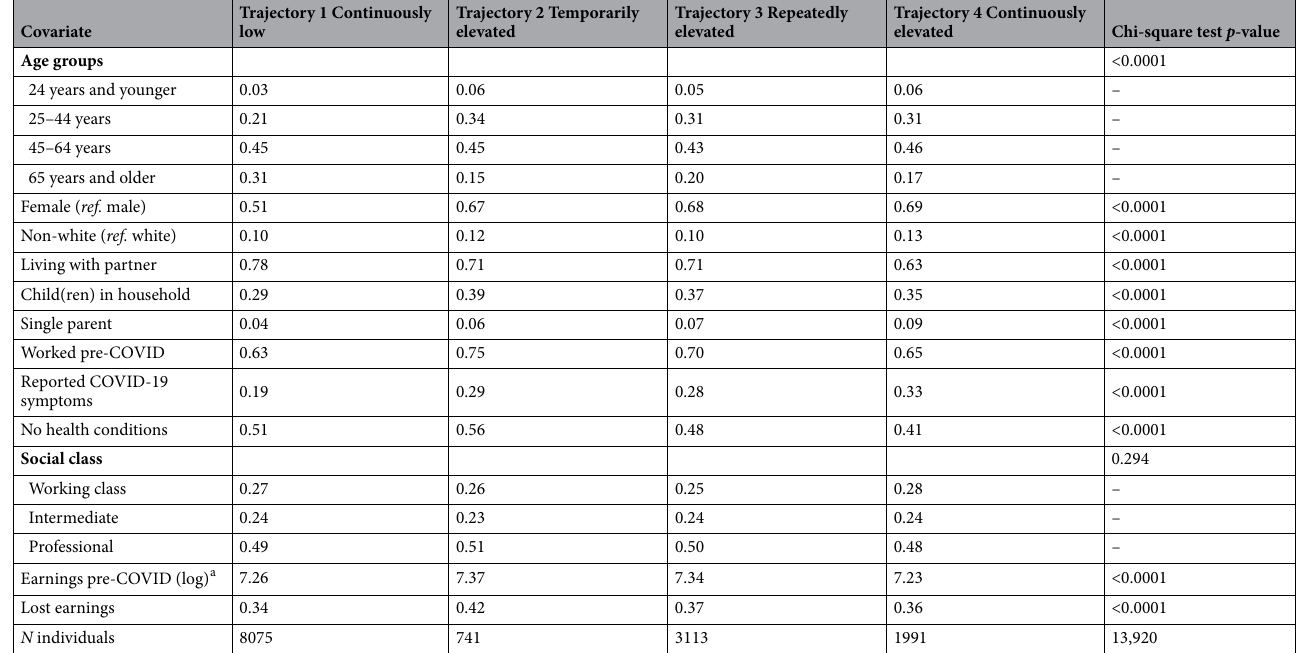
Table 2. Proportions/means of covariates by trajectories. Based on individuals with complete information on all covariates at baseline. a